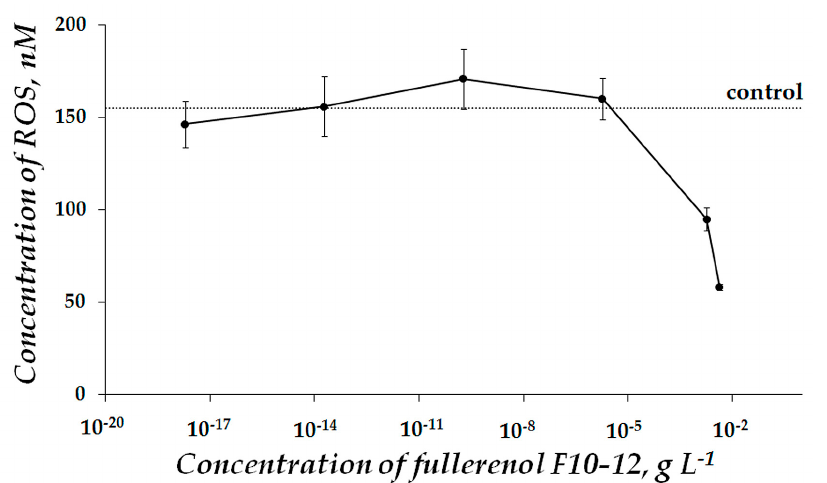
Figure 2. Concentration of ROS in the enzymatic assay system at different concentrations of full- erenol F10-12. Incubation time—45 min. ROS concentration in the control sample is 155 nM. The physicochemical mechanism of fullerenol’s toxic influence on the